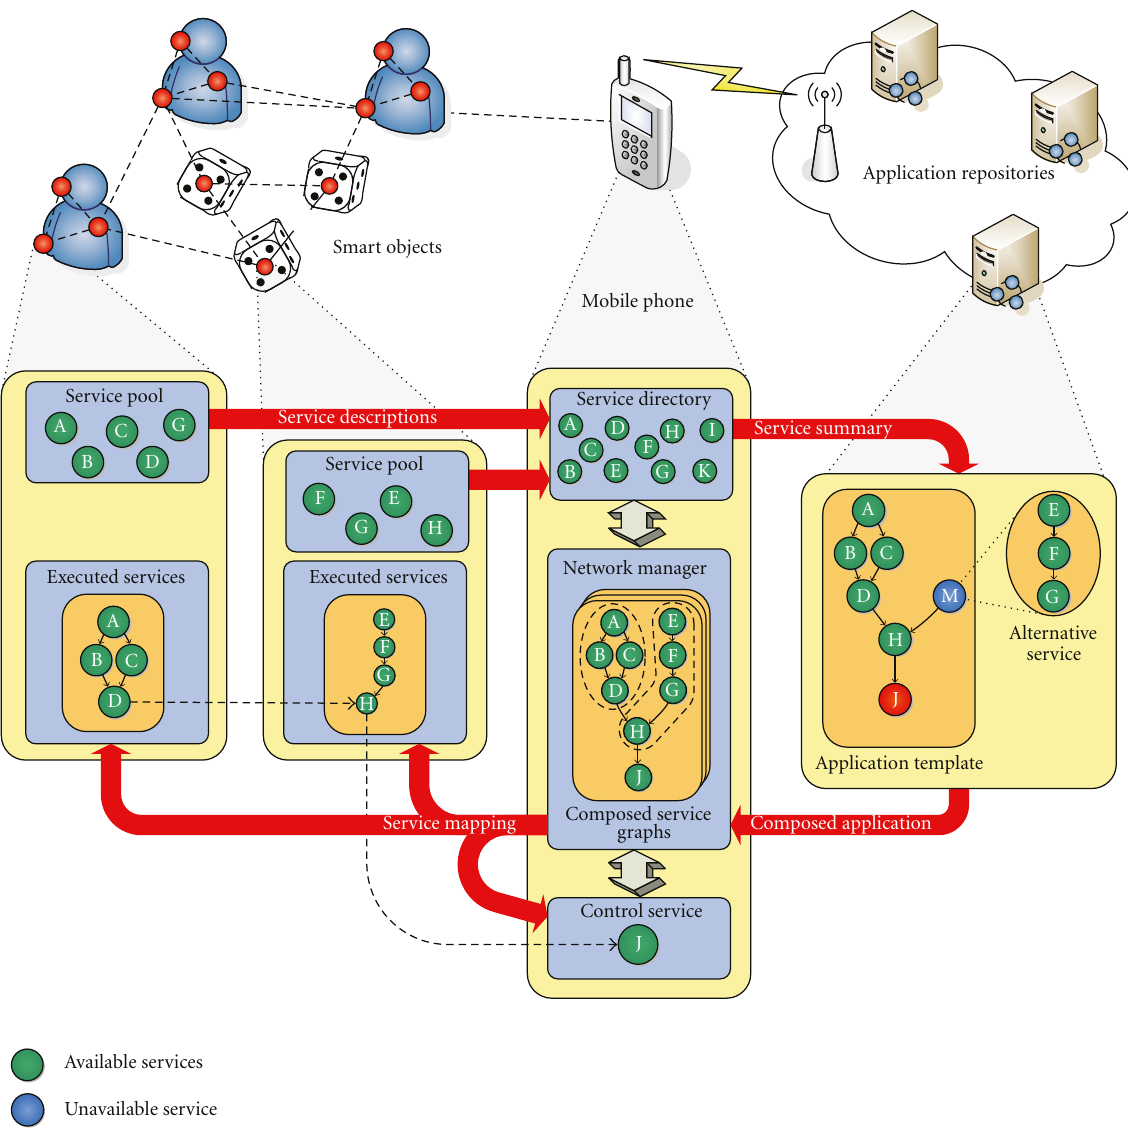
Figure 1: The Titan framework for pervasive applications comprises tiny tasks running on Titan nodes in the PAN (left), a mobile device (center) and Internet application repositories (right). The network manager on the mobile phone collects device and service information available in the PAN in its service directory. It provides this information to application repositories on the Internet. These repositories compose possible applications at runtime and send the resulting service graphs back to the network manager, which maps the services onto individual nodes for